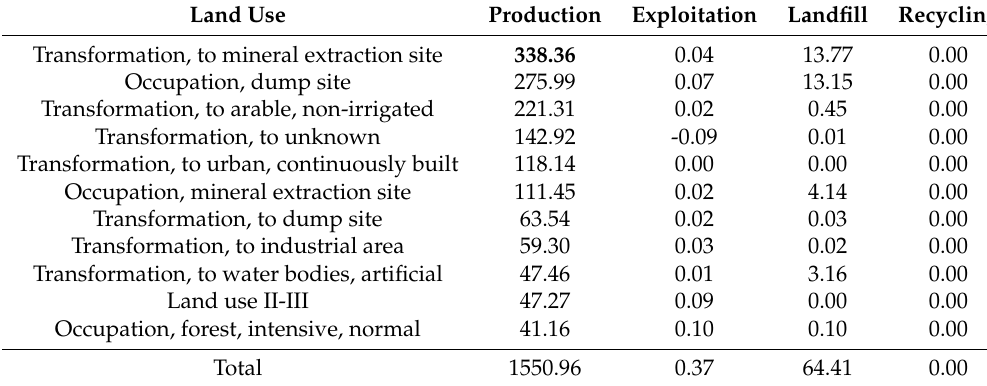
Table 12. Results of grouping and weighting of after-e ff ects of environmental land use processes, occurring in the 1 megawatt photovoltaic power plant [unit: